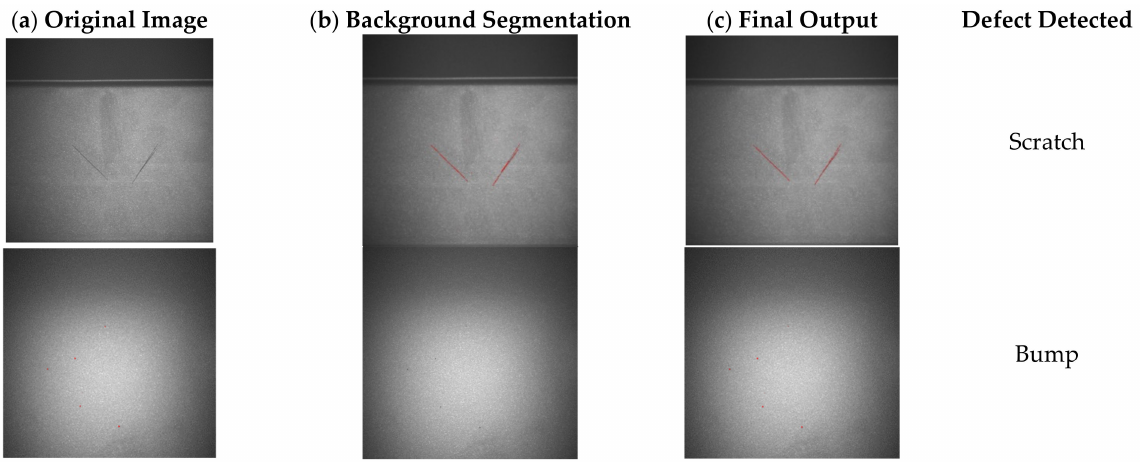
Figure 9. Computer Vision-based Segmentation for Black Color Products.